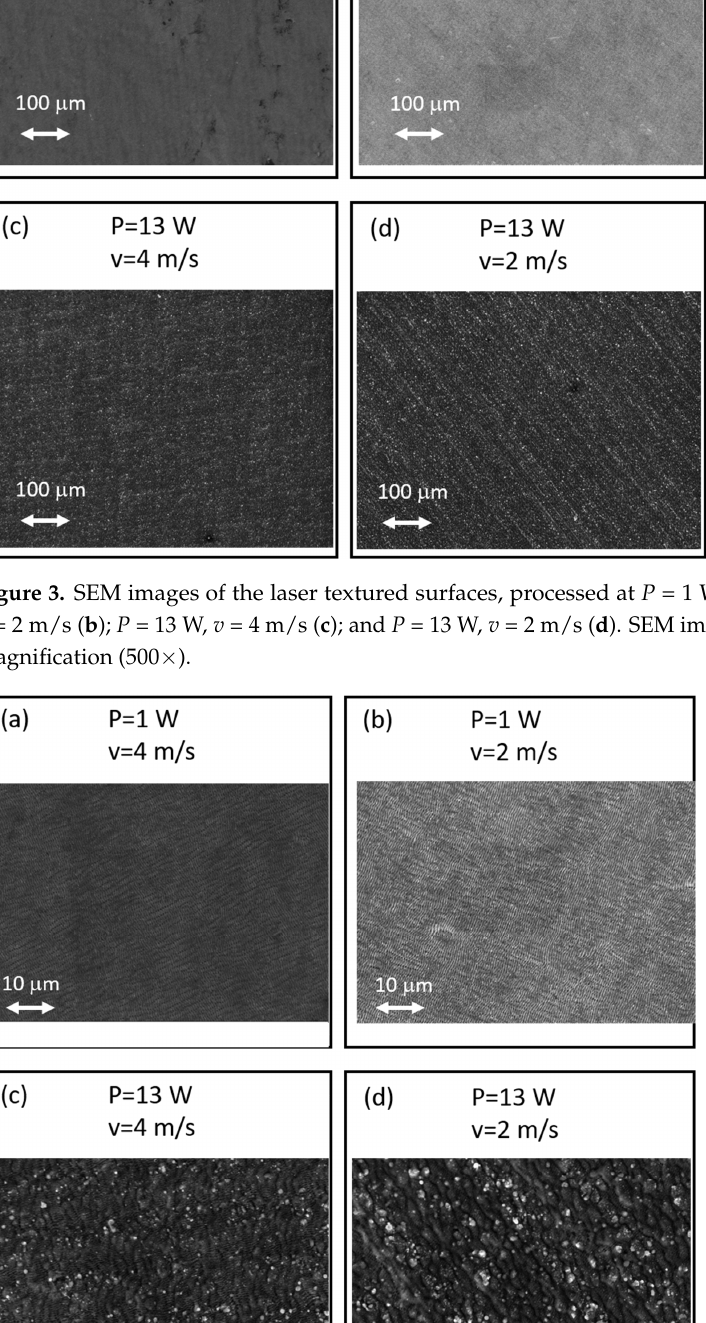
Figure 4. SEM images of the laser textured surfaces, processed at P = 1 W, v = 4 m/s ( a ); P = 1 W, v = 2 m/s ( b ); P = 13 W, v = 4 m/s ( c ); and P = 13 W, v = 2 m/s ( d ). SEM images were acquired at high magnification (3000×).